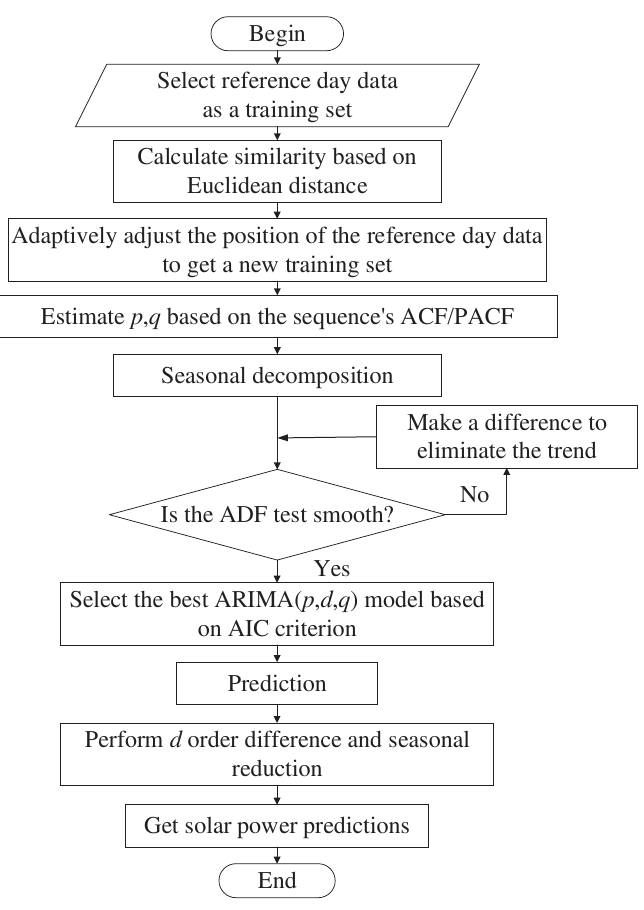
Figure 1. The flow chart of ASARIMA